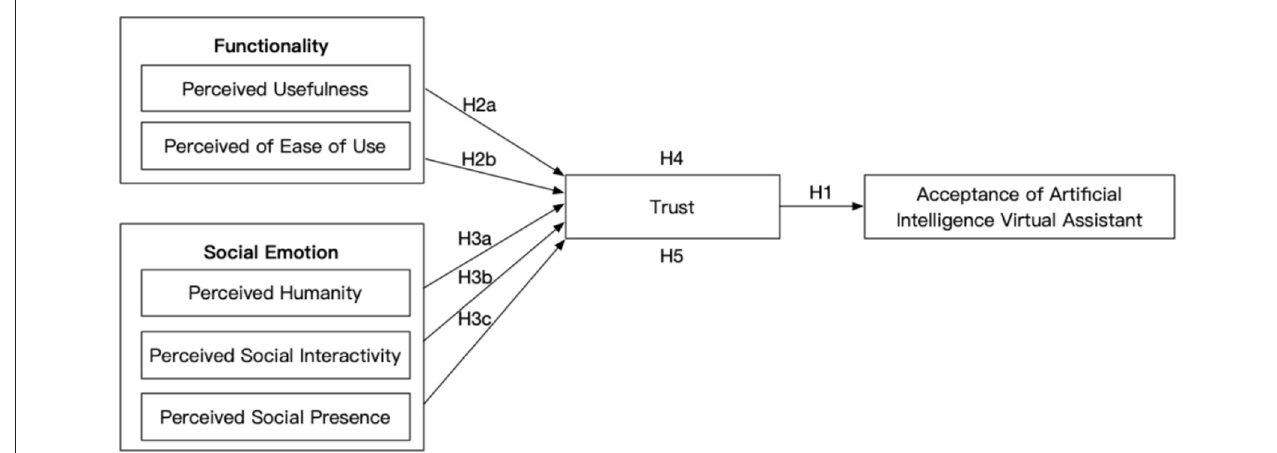
FIGURE 1 | Artificial intelligence virtual assistant acceptance